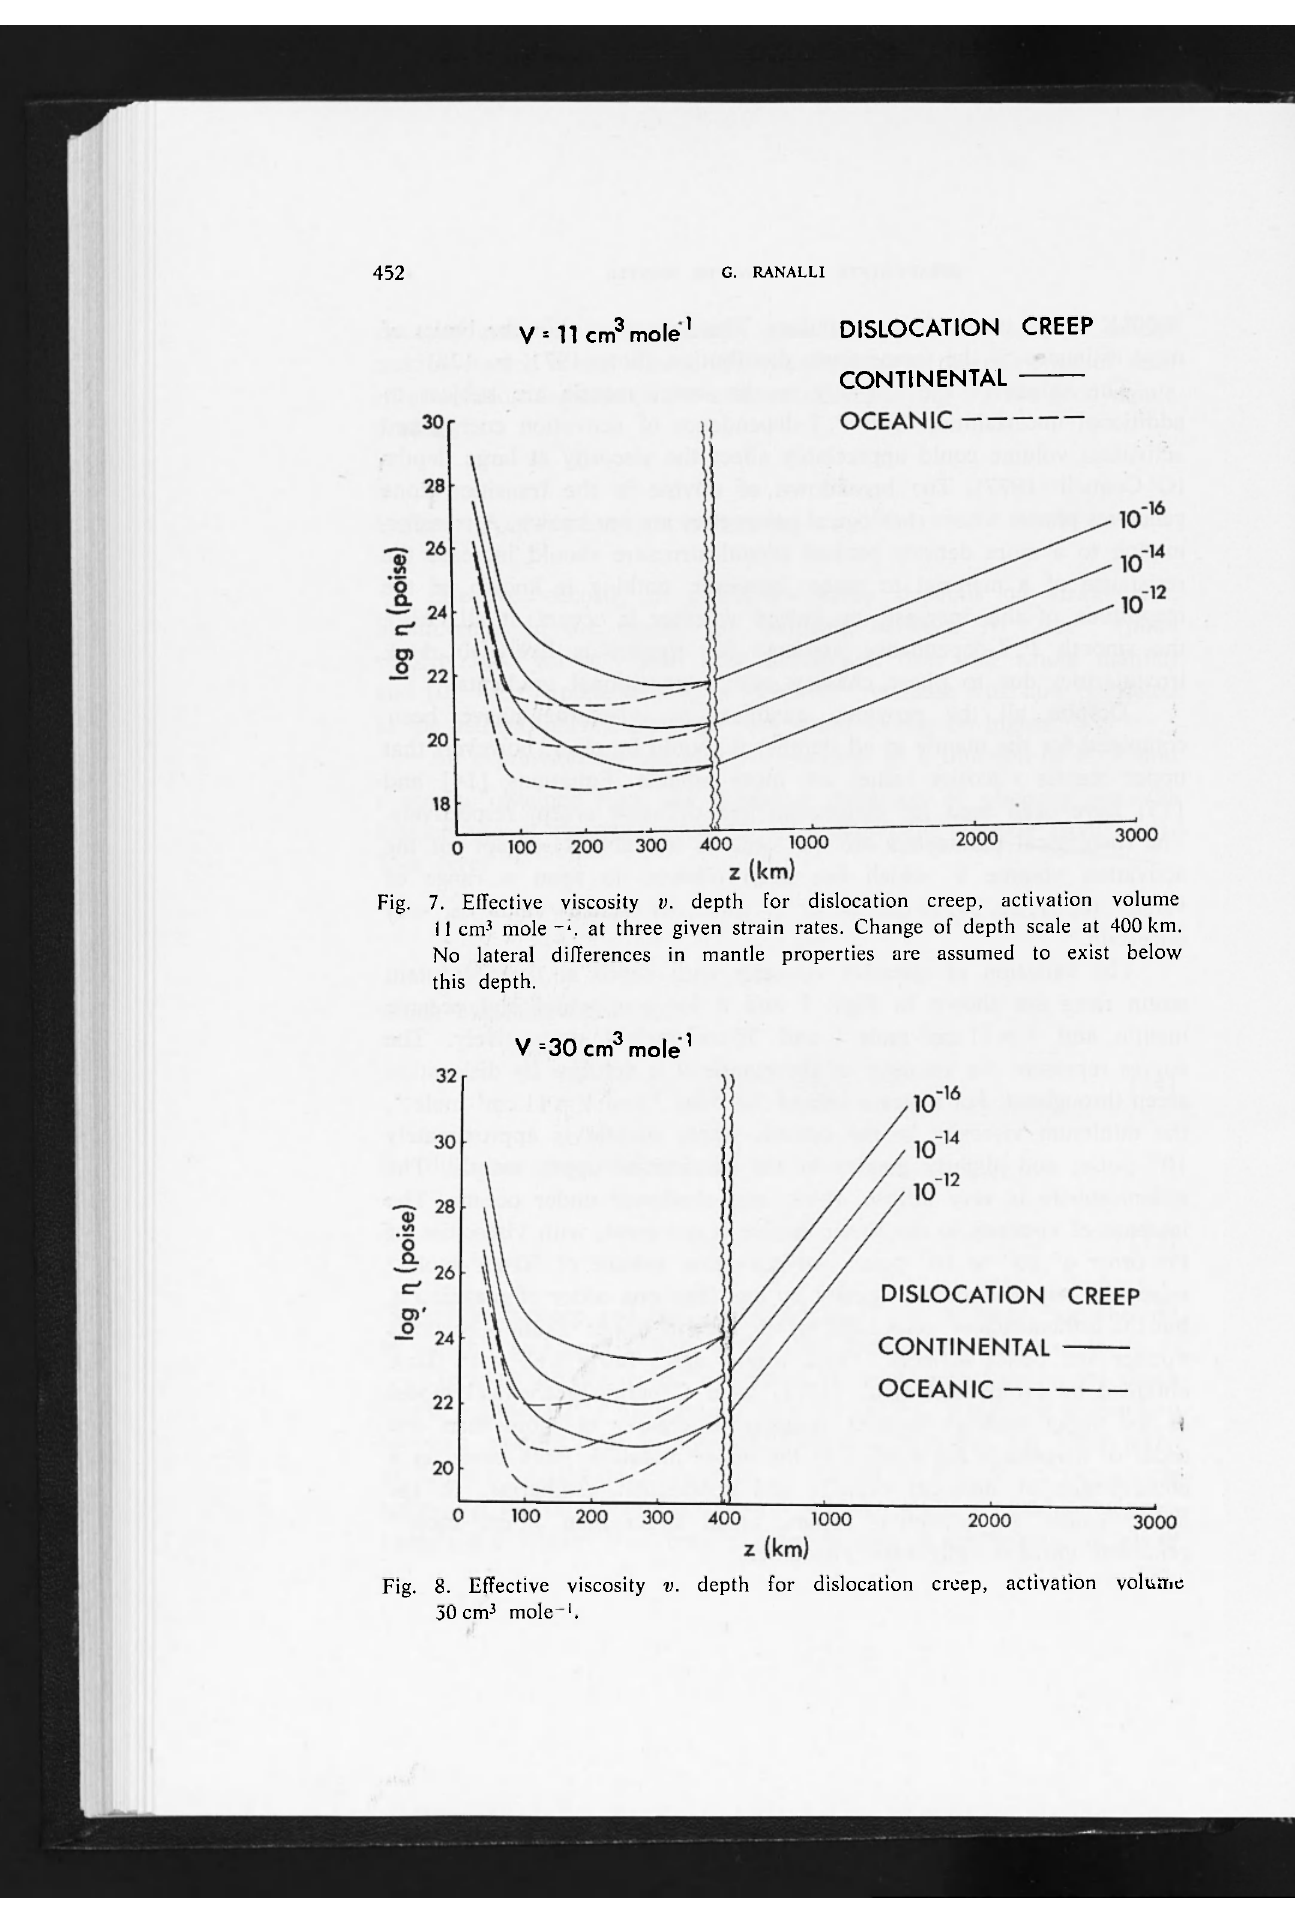
Fig. 7. Effective viscosity v. depth for dislocation creep, activation volume 11 cm 3 mole at three given strain rates. Change of depth scale at 400 km.